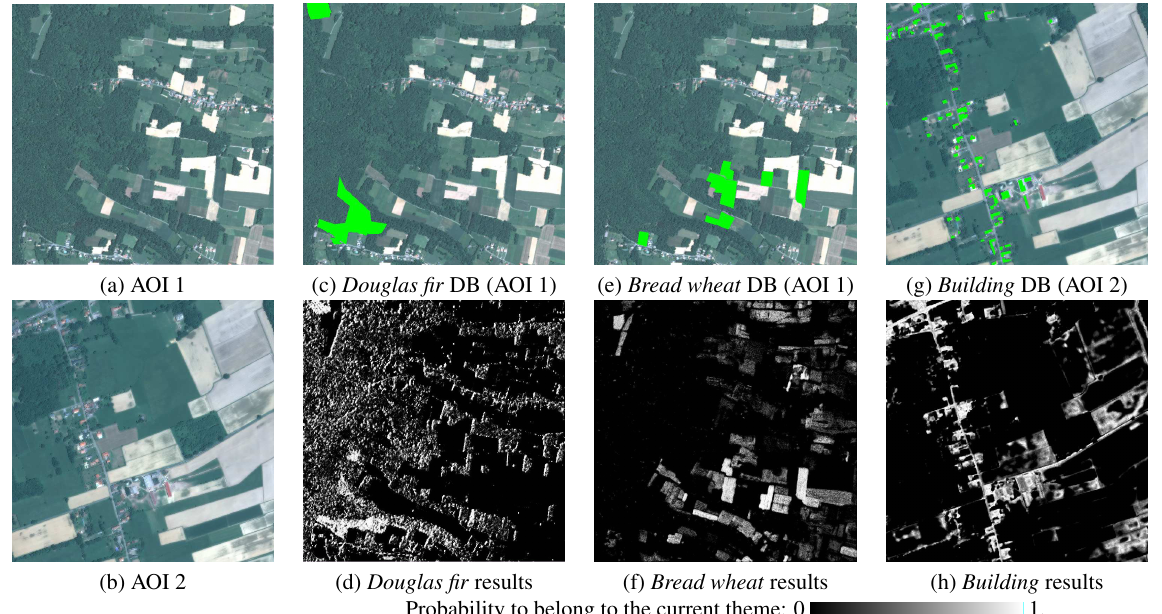
Figure 2: (a) and (b) The two specific areas of interest (AOI 1 and 2) of the Pl´eiades image. DB and the probability result at theme level for: (c) and (d) the douglas fir theme (AOI 1), (e) and (f) the bread wheat theme (AOI 1), (g) and (h) the building theme (AOI 2). No DB fusion has been performed